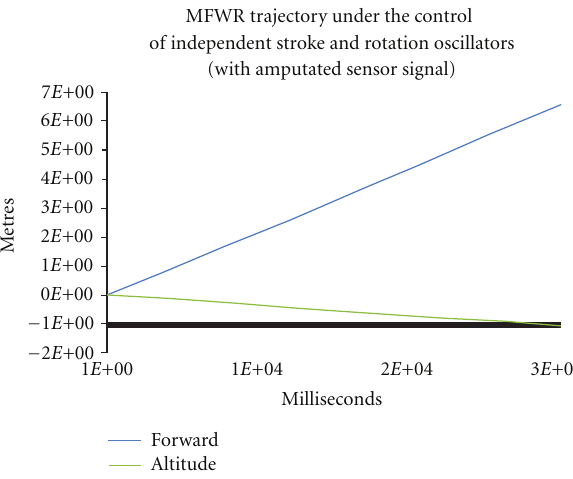
Figure 30: The MFWR trajectory produced by the controller during the lesion study performed with the techniques shown in Figure 28. It can be observed that the amputated two independent stroke and rotation oscillators, in absence of the external sensor, were partially successful in controlling the MFWR to have accept- able cruise behavior in it, suggesting the requirement of the external sensor ingestion to achieve the acceptable cruise control.